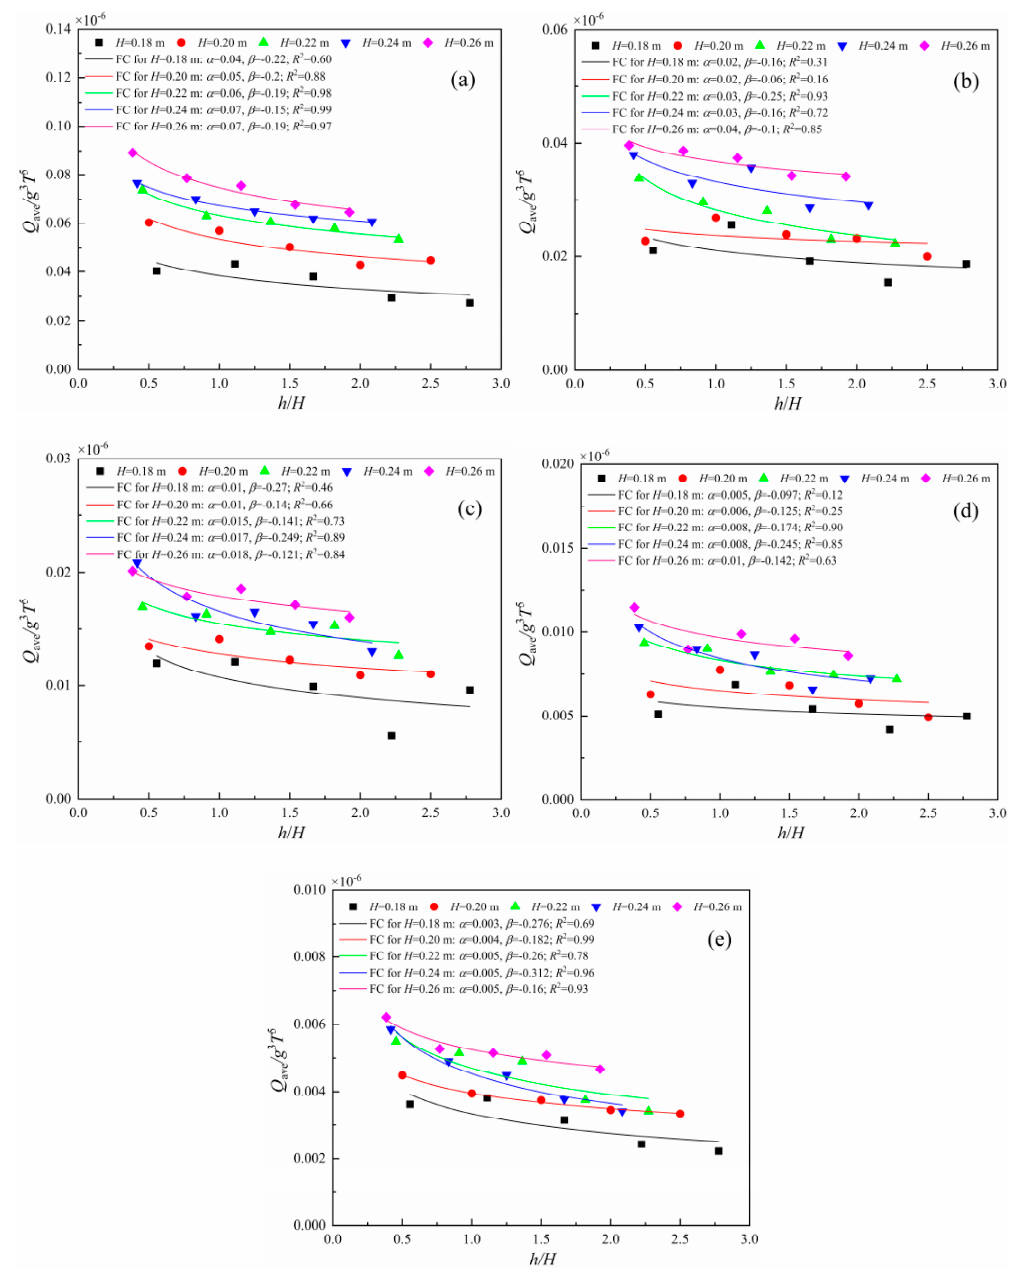
Figure 10. Q ave / g 3 T 5 relationship with h/H . ( a ) T = 1.5 s; ( b ) T = 1.8 s; ( c ) T = 2.1 s; ( d ) T = 2.4 s; Figure 10 Q ave / g 3 T 5 relationship with h/H. ( a ) T = 1.5 s; ( b ) T = 1.8 s; ( c ) T = 2.1 s; ( d ) T = 2.4 s; ( e ) T = 2.7 s. ( e ) T = 2.7